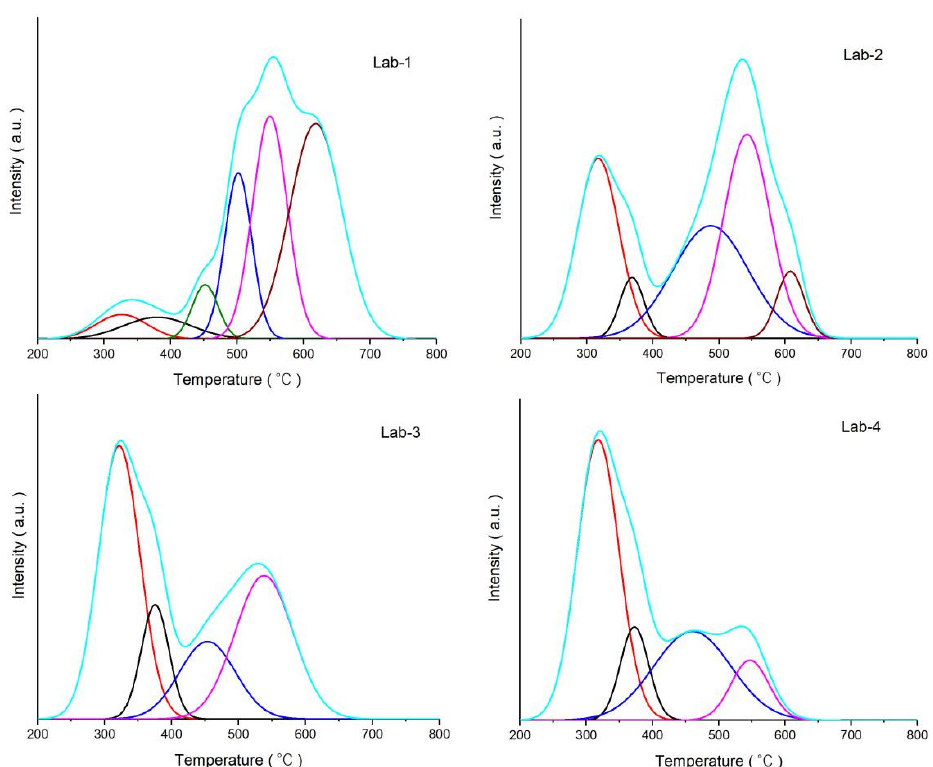
Figure 7. Peak splitting and fitting of H 2 -TPH profiles of the four catalyst samples (color correspon- dance by, red: carbidic carbon; black: amorphous carbon; green: β carbon; blue: bulk carbon 1; purple: bulk carbon 2; brown: bulk carbon 3). Table 2. Attributed temperature of carbon species corresponding to the surface reaction of the H 2 -TPH process over catalysts with different potassium loading. Sample